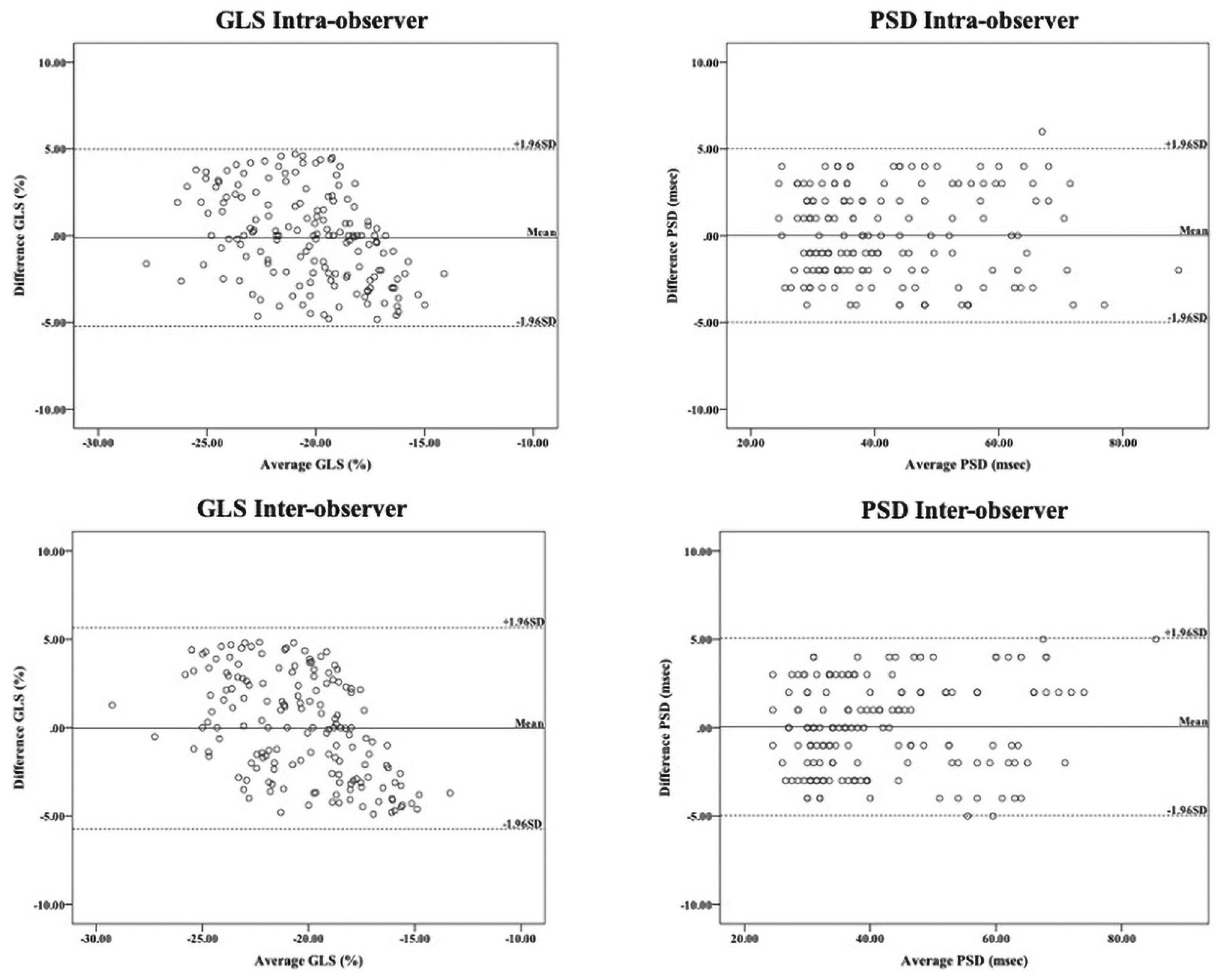
Figure 3. Reproducibility within intra-observer and inter-observer measurements for the GLS and PSD